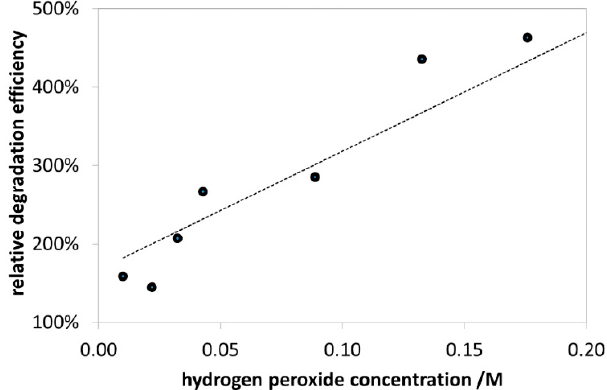
Figure 11. Effect of H 2 O 2 concentration on the relative efficiency of the photocatalytic MB degradation. Concentrations: NP-3 = 400 mg/L, MB = 1.5 × 10 − 5 mol/L, and initial pH = 7.5.